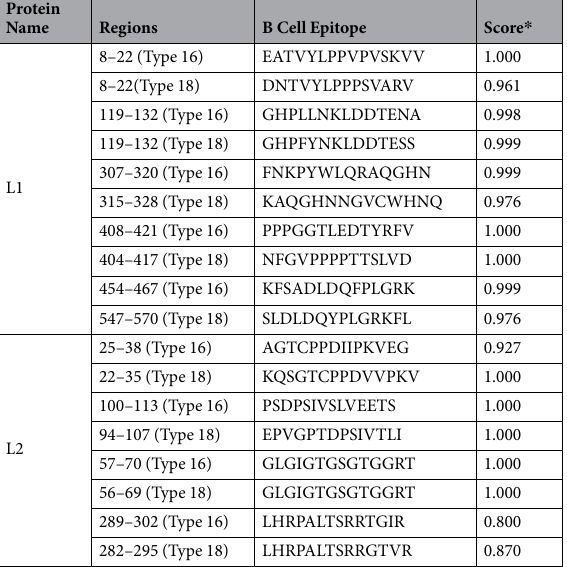
Table 3. B-cell epitope identification of HPV L1 & L2 conserved regions. * Higher rates show better quality of epitope